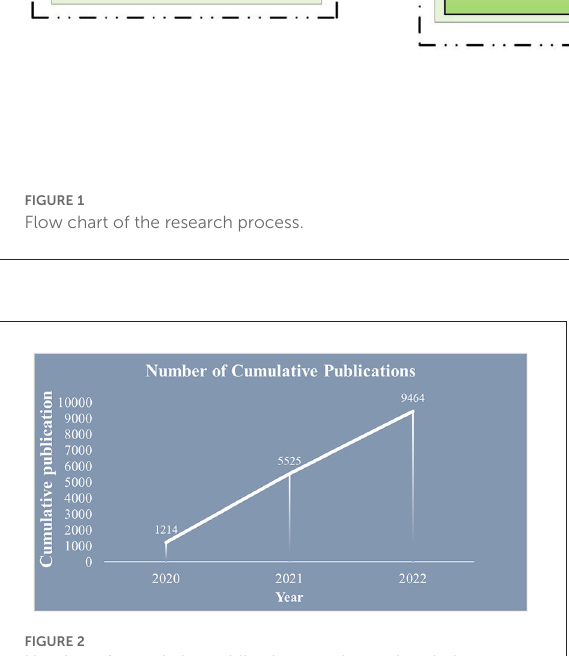
FIGURE2 Number of cumulative publications on depression during